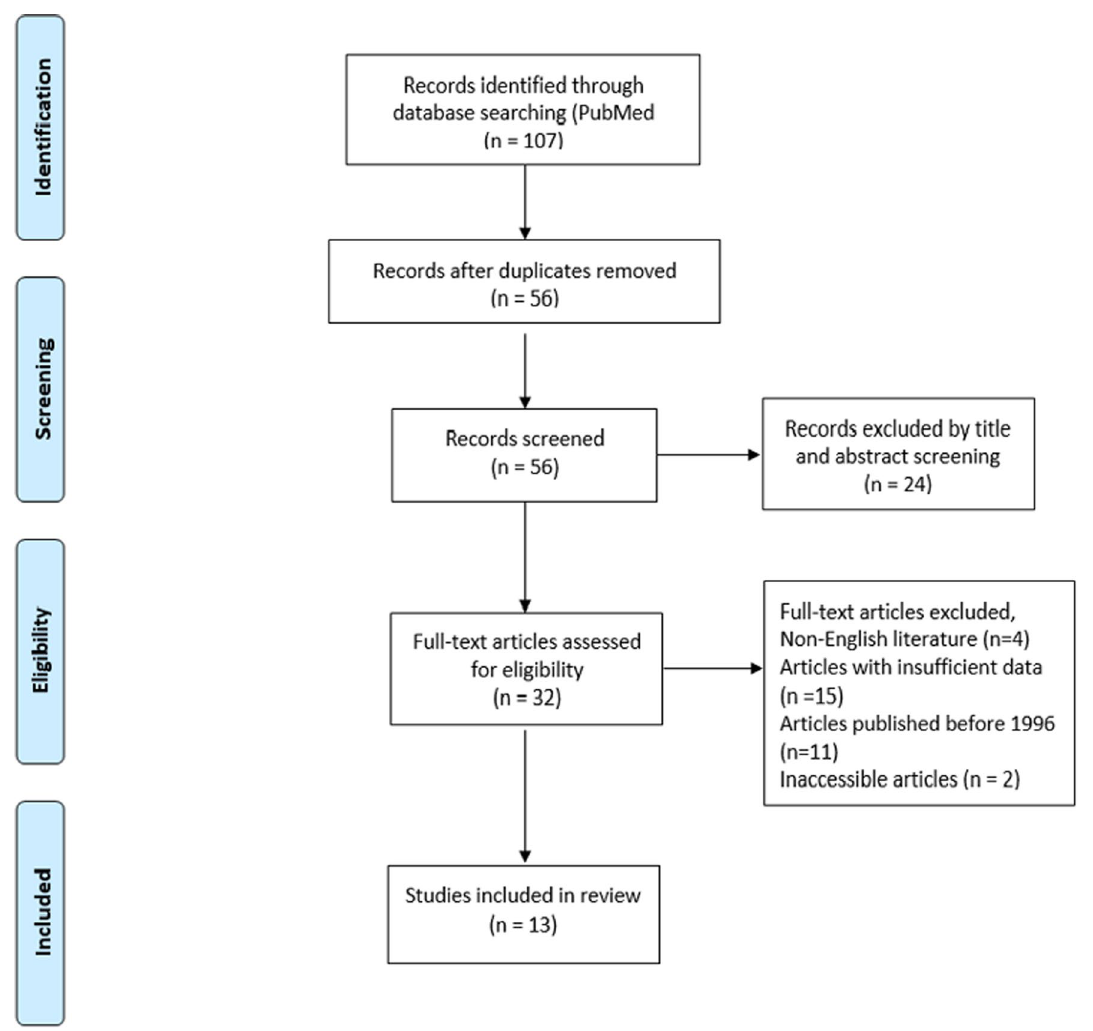
Fig. 1 Flow chart of the